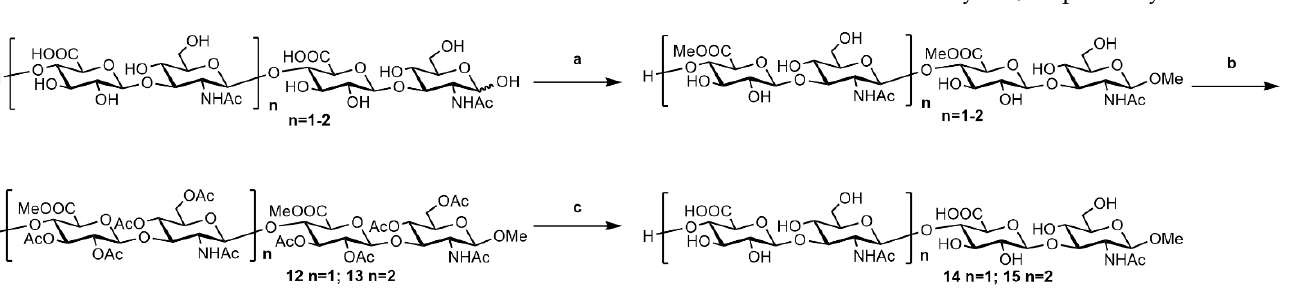
Figure 4. Synthesis of o-HA 4 OMe ( 14 ) and o-HA 6 OMe ( 15 ). Reagents and conditions: ( a ) 0.5 M HCl, MeOH, 0 °C to rt, overnight; ( b ) Ac 2 O, Et 3 N, DMAP, DCM, 2 h, 21% for 12 , 19% for 13 . ( c ) LiOH/H 2 O 2 , THF/H 2 O, − 5 °C to rt, then 4 M NaOH, MeOH, 0 °C to rt, 85% for 14 , 82% for 15 .